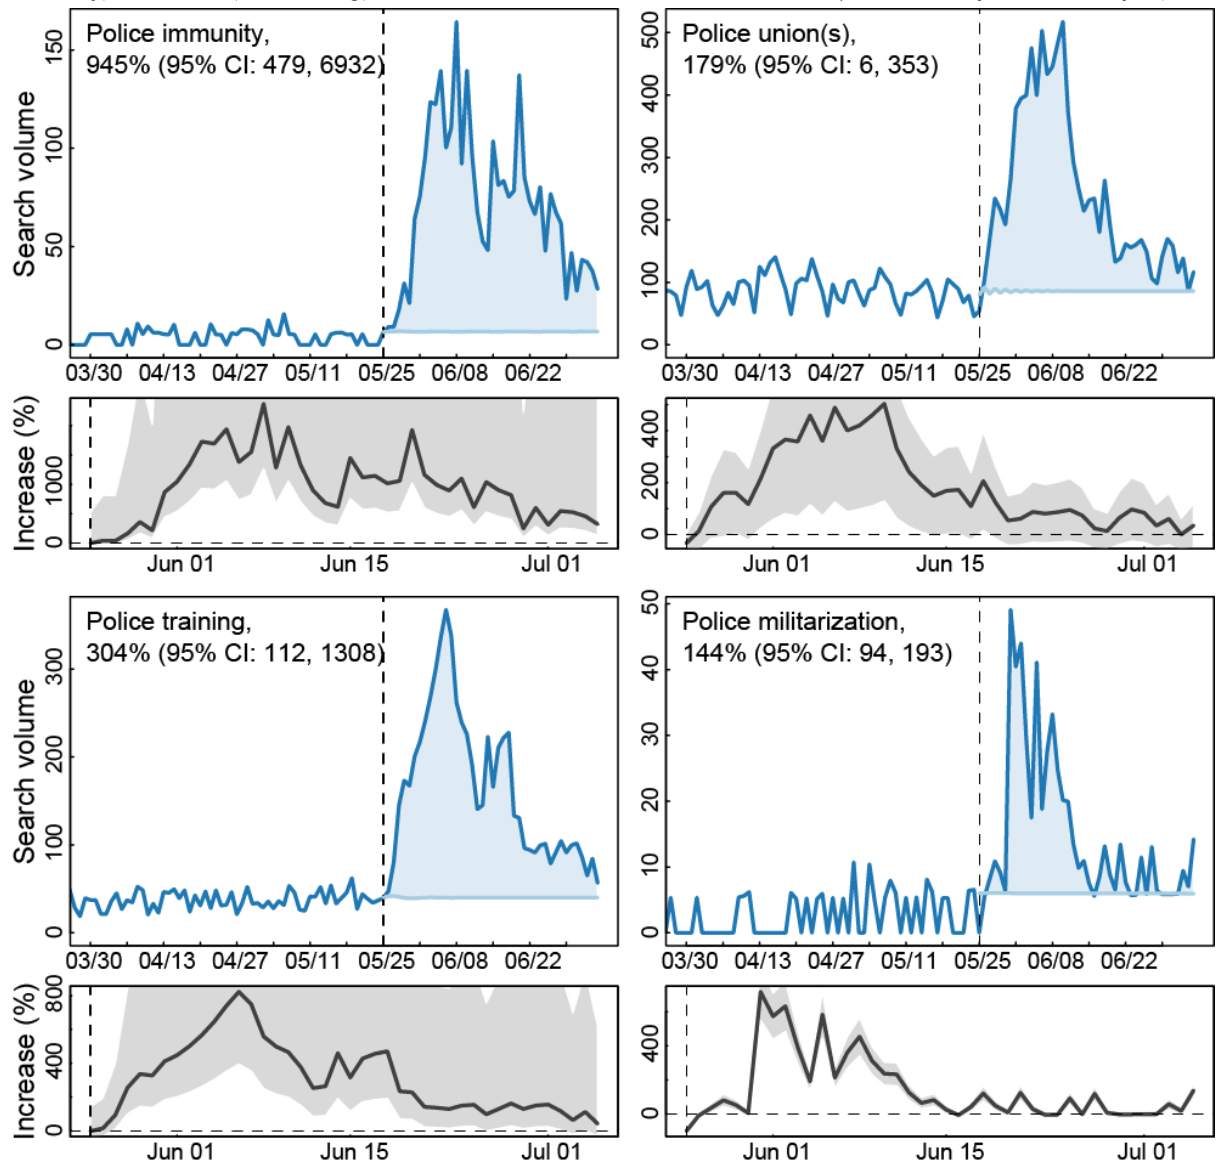
Figure 2. Internet searches for specific police reforms following the death of George Floyd. Queries included all searches with the terms “police”